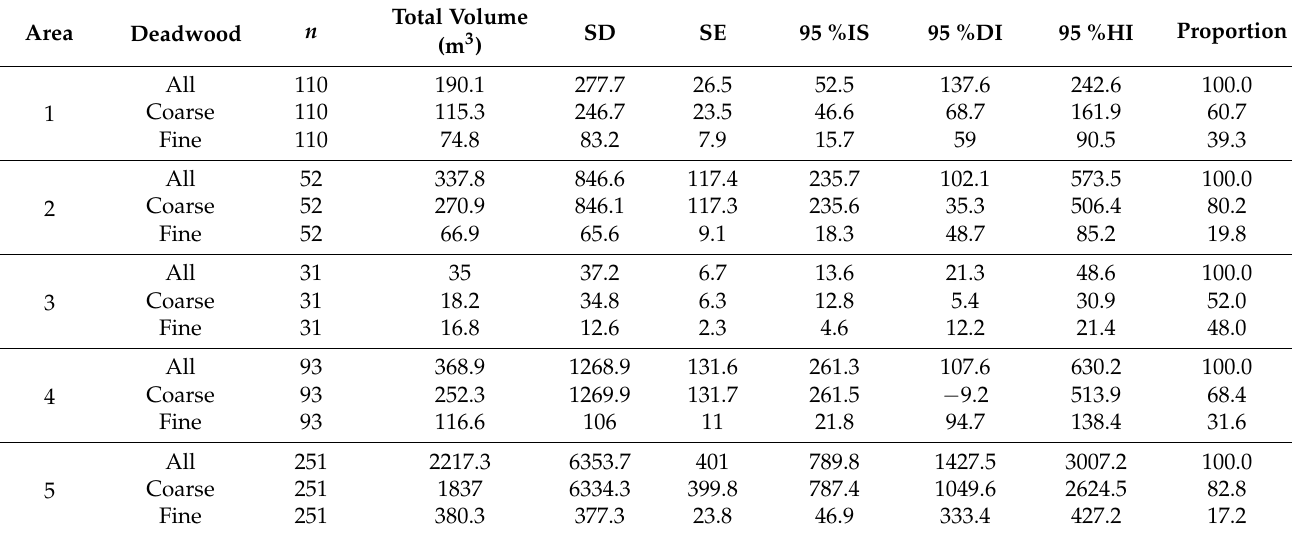
Table 1. Total volume of deadwood in disturbed areas based on inventory results.